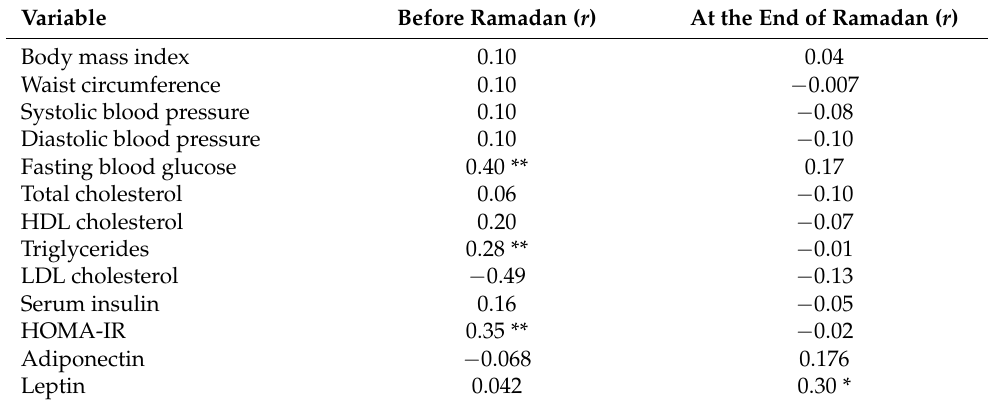
Table 4. Correlations between PCSK9 and studied variables before and at the end of Ramadan fasting. Variable